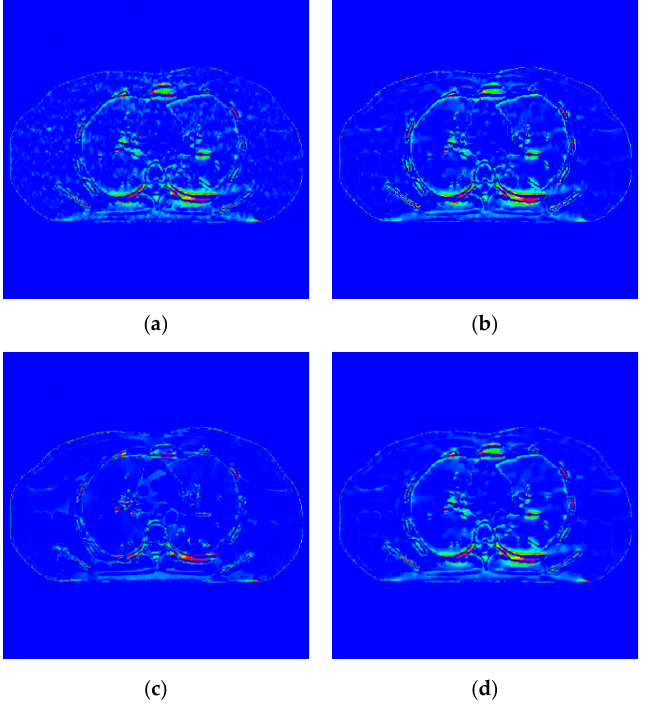
Figure 12. Difference image of incident photon number 5 × 10 3 . ( a ) EP iterative reconstruction difference image; ( b ) DCT image post-processing principle; ( c ) DL iterative reconstruction algorithm; ( d ) learning sparse transformation image.